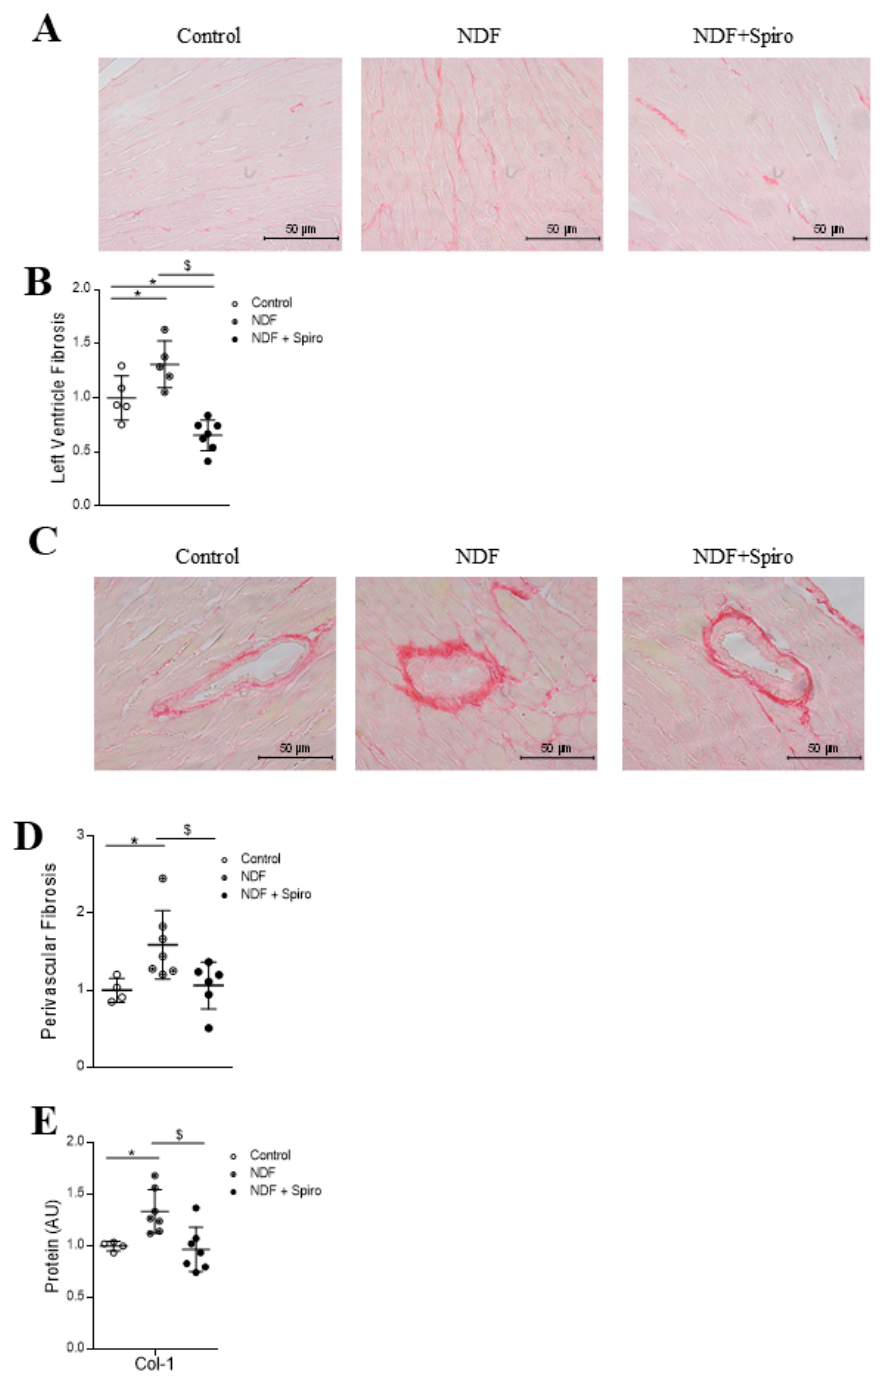
Figure 1. E ff ects of Spironolactone on cardiac fibrosis in a mouse model of myxomatous valve disease. Representative microphotographs of mouse myocardial sections with Sirius red staining for interstitial ( A ) and perivascular ( C ) fibrosis. Individual datapoints show the quantification of interstitial fibrosis (* p = 0.0452 Nordexfenfluramine (NDF) vs. control; $ p = 0.0001; * p = 0.0166 NDF + Spiro vs. control) ( B ) and perivascular fibrosis (* p = 0.0307; $ p = 0.035) ( D ). Quantification of collagen type I (* p = 0.0329; $ p = 0.0007) ( E ). The box plots show the individual datapoints and the horizontal bars indicate the mean and SEM in arbitrary units versus the control group. Magnifications 40 × (Scale bar 50 µ m). The results were analyzed using one-way analysis of variance (ANOVA), followed by Tukey’s multiple comparisons tests. * vs. control, $ vs. NDF.